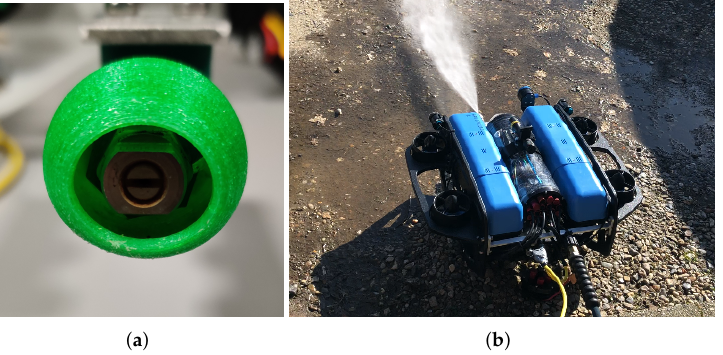
Figure 3. Photos of water jet nozzle used on BlueROV2. ( a ) Photo of the applied high-pressure water jet nozzle. ( b ) Photo of the BlueROV2 while the water jet is utilized.